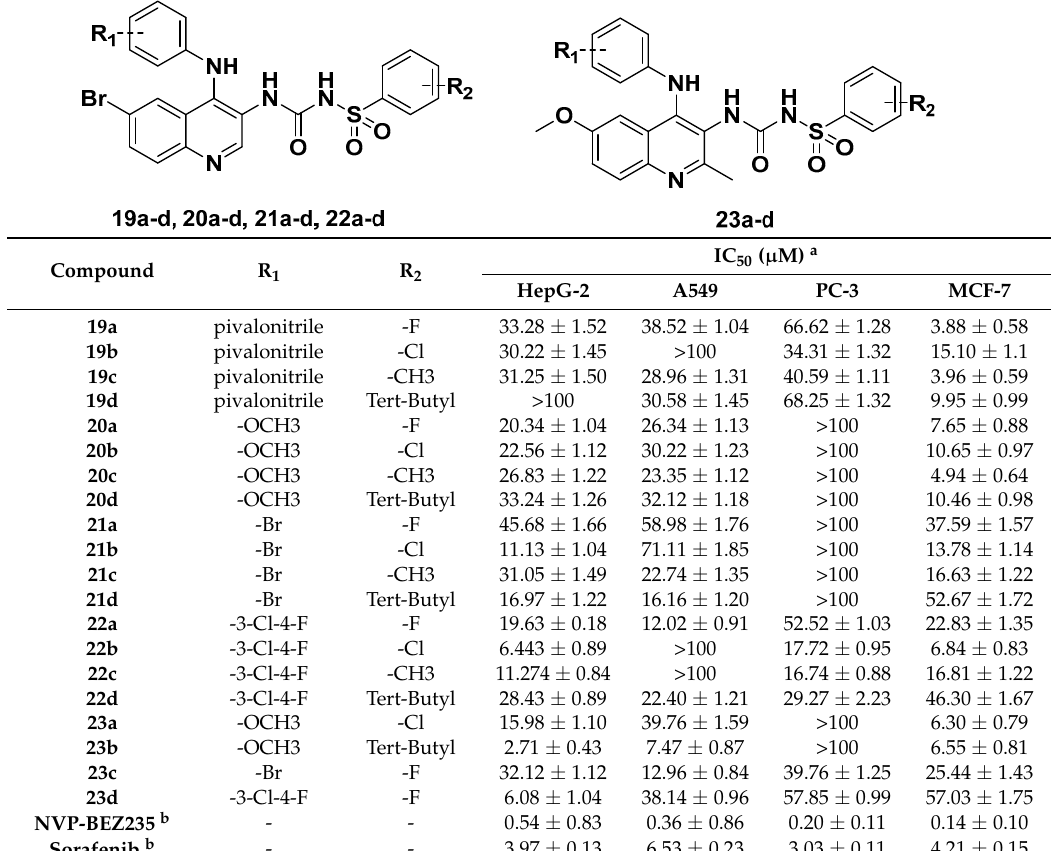
Table 1. Structures and cytotoxicity of compounds 19a – d , 20a – d , 21a – d , 22a – d and 23a – d .